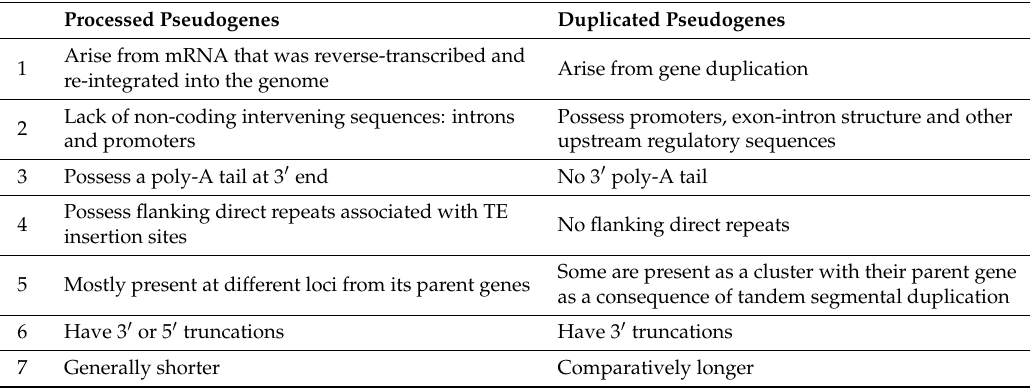
Table 1. Comparison between processed and duplicated